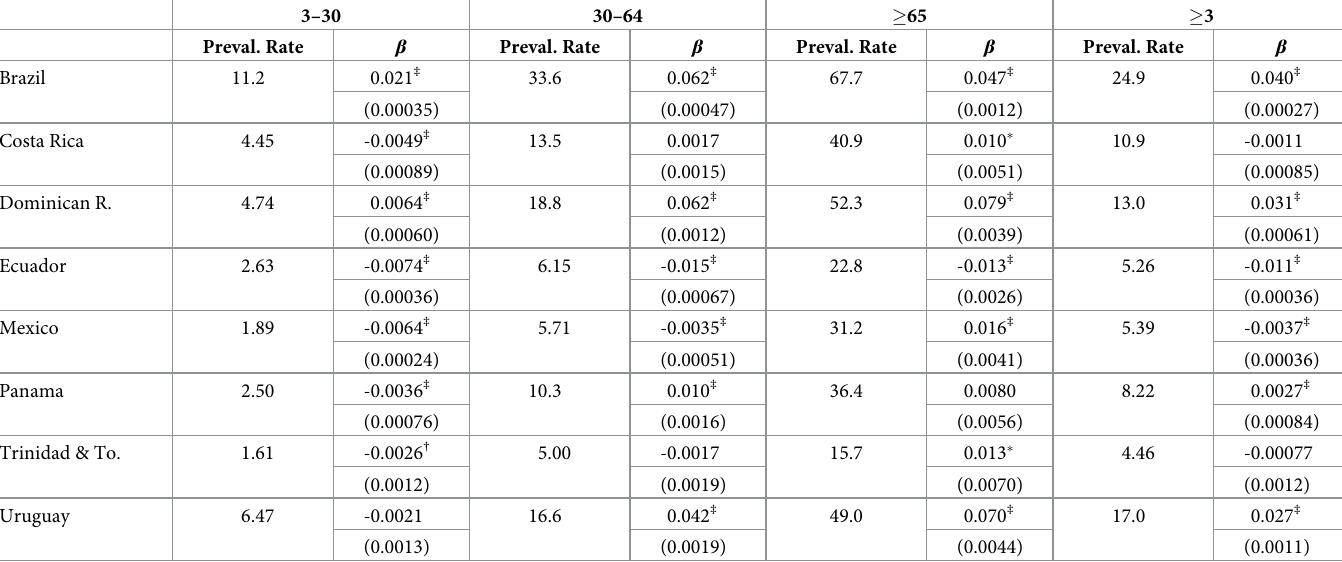
Table 3. Gender differences in disability prevalence by age group: Estimates. Preval.